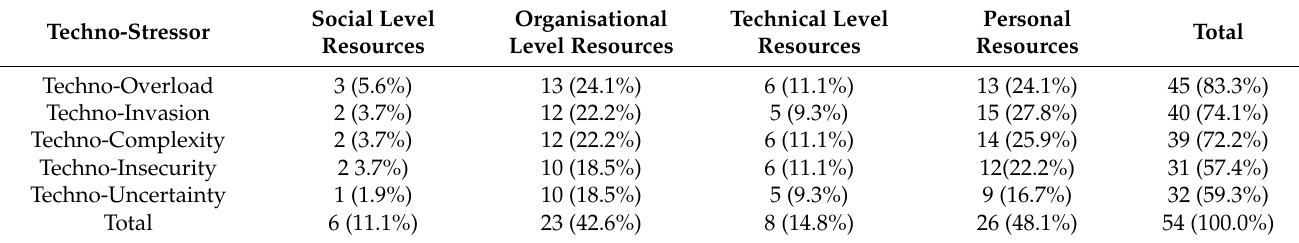
Table 4. Frequencies of techno-stressors and resources in quantitative studies ( n = 54) 1